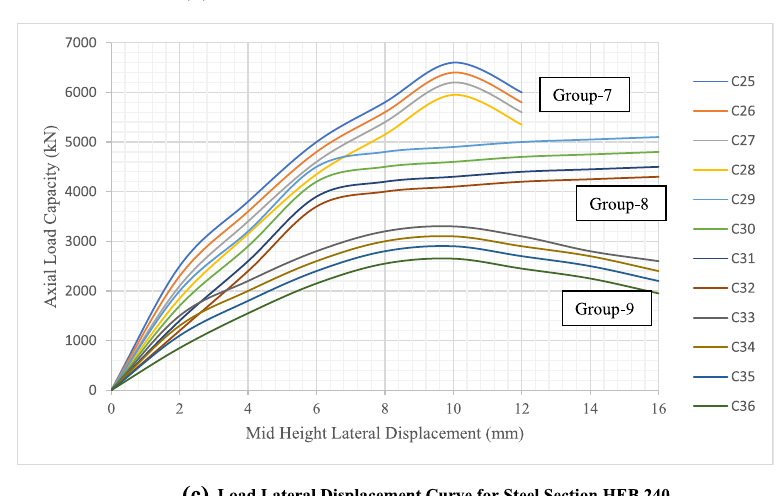
Fig. 6 Load lateral displacement curve for various steel